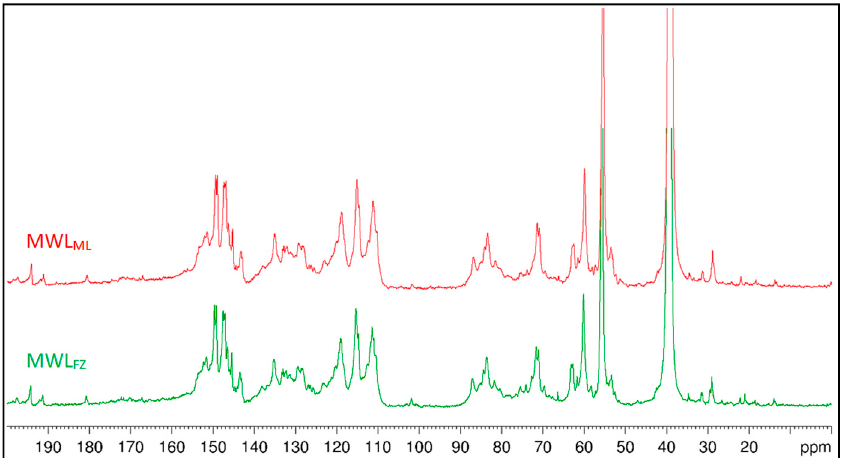
Figure 7. Quantitative 13 C NMR spectra of MWL ML and MWL FZ from ginkgo shells.